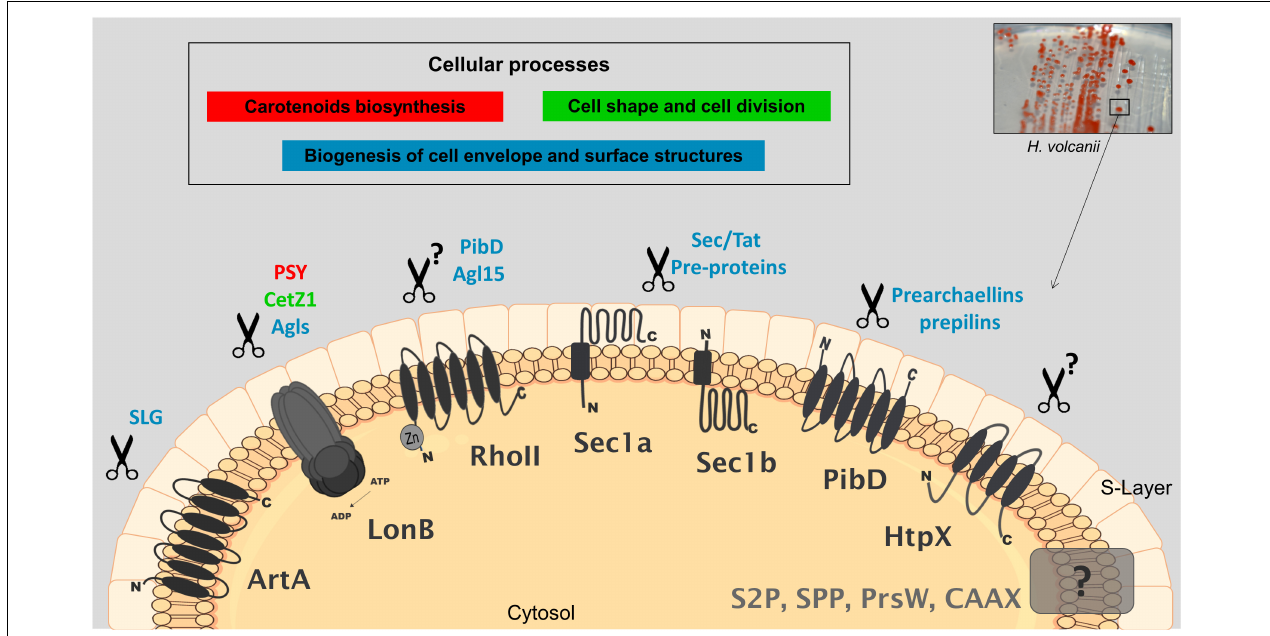
FIGURE 1 | Cellular processes and potential targets of membrane-localized proteases in Haloferax volcanii. Proteases that have been characterized by genetic, biochemical and/or proteomics studies are shaded in black; those uncharacterized are shaded in gray; proposed biological functions and associated potential targets are indicated with the same color. Genetics combined with proteomics have shown that LonB affects the degradation of key proteins involved in carotenogenesis (PSY), cell shape determination (CetZ1) and likely the glycosylation of SLG (several GTs). Rhomboid RhoII is implicated in the biogenesis of a sulfoquinovose-containing oligosaccharide as a mutant deleted in the rhoII produces a truncated version of this oligosaccharide. PibD and Agl15 are suggested as potential targets of RhoII based on differential proteomics on wt and a mutant lacking rhoII . Anchoring of the SLG into the cell surface involves the proteolytic processing of a C-terminal sorting signal by the peptidase archaeosortase A (ArtA) followed by lipid attachment, this mechanism has been substantiated by various types of evidence. SPIs Sec11a/b and TFPP-like PibD process pre-proteins for membrane insertion, secretion and for cell surface structures. Protease homologs of HtpX, S2P, SPP, CAAX prenyl-proteases, and PrsW have been detected by differential proteomics. HtpX was suggested to participate in stress response. Additional details and the corresponding references are described in the